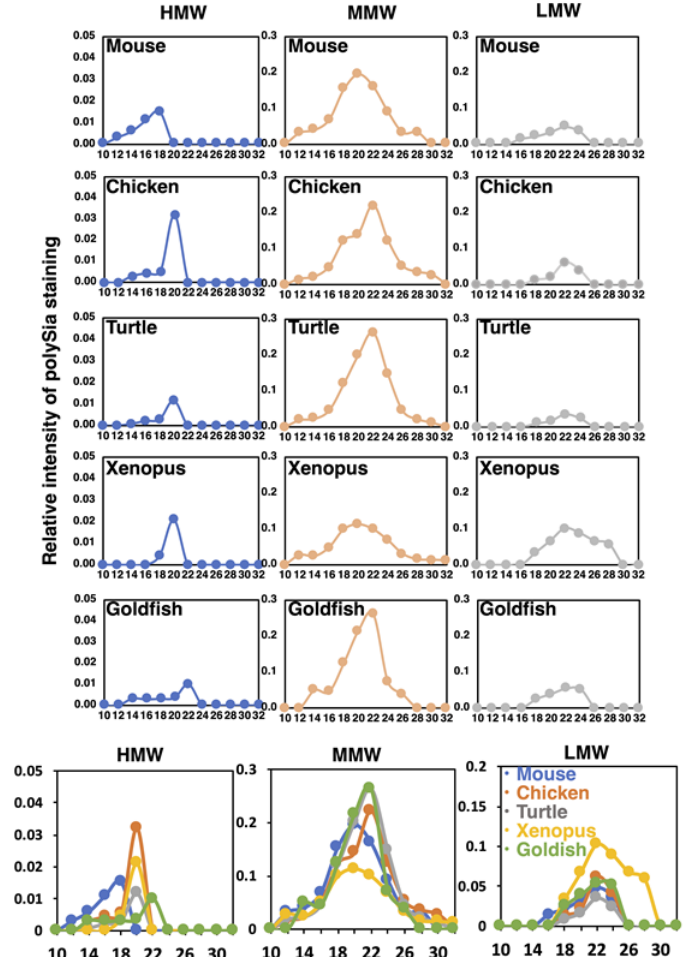
Figure 9. Sephacryl S-500 chromatograms of polySia-NCAM of brain homogenates from five vertebrate brains. Brains from five di ff erent vertebrates (mouse, chicken, turtle, xenopus, and goldfish, n = 1) were analyzed by the gel filtration. The elution profiles were monitored by native-PAGE / Western blotting of each fraction using 12E3 (Figure S3A). The left, middle, and right panels for each animal brain show the elution profiles in the regions of HMW (above 720 kDa), MMW (480–720 kDa), and LMW (less than 480 kDa), respectively. The sum of the intensity of the immunostaining of the fractions was set to 1.0. At the bottom panels, merged images of the profiles for five di ff erent vertebrate brains are shown.